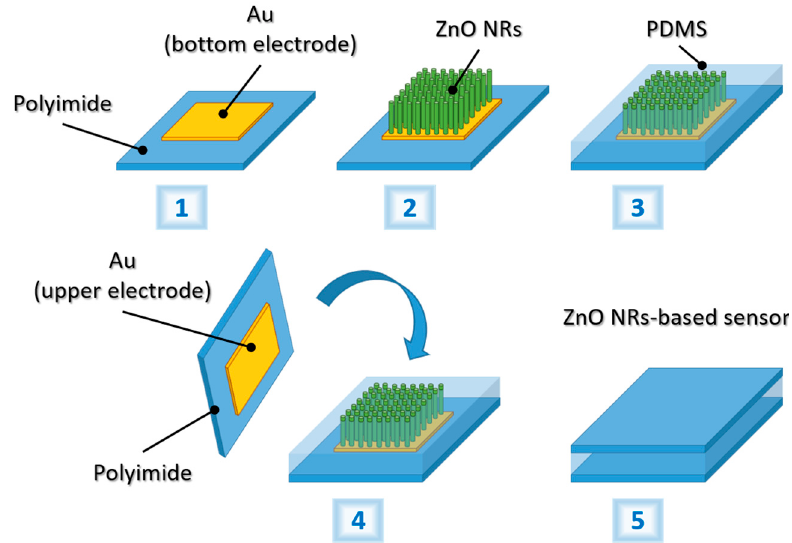
Figure 1. Schematics of the growth of ZnO NRs via seedless hydrothermal process on Au-coated polyimide substrates and fabrication of the pressure sensor.